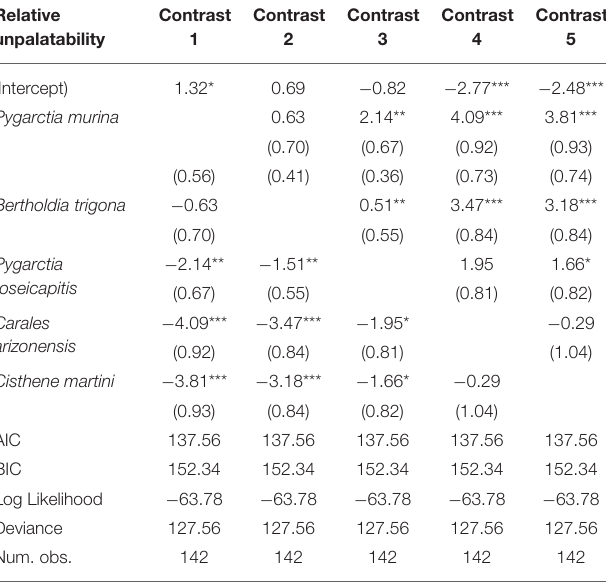
TABLE 1 | Generalized linear model of nonchalant flight behavior. Relative nonchalance